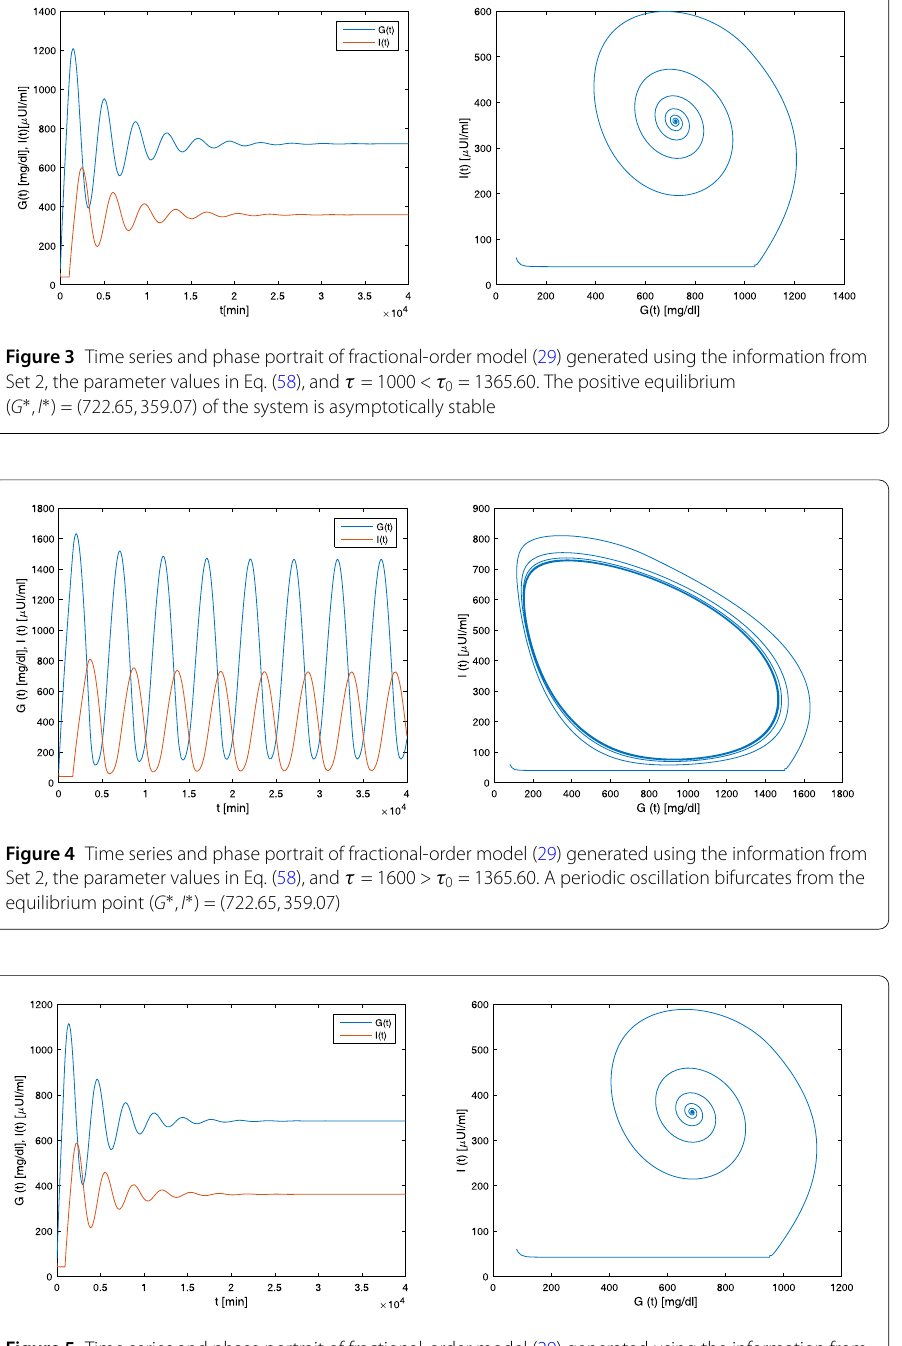
tain Re [ ds ] τ = τ = 3.650184 × 10 –7 (cid:9) = 0. Thus, by Theorem 5.1, the positive equilibrium 0 , ω = ω 0 d τ point for this case is asymptotically stable when τ = 900 < τ 0 , which is shown in Fig. 5 for t ∈ [0,40,000]. However,it is unstable and a Hopf bifurcation occurs when τ = 1500 > τ 0 , as displayed in Fig. 6 for t ∈